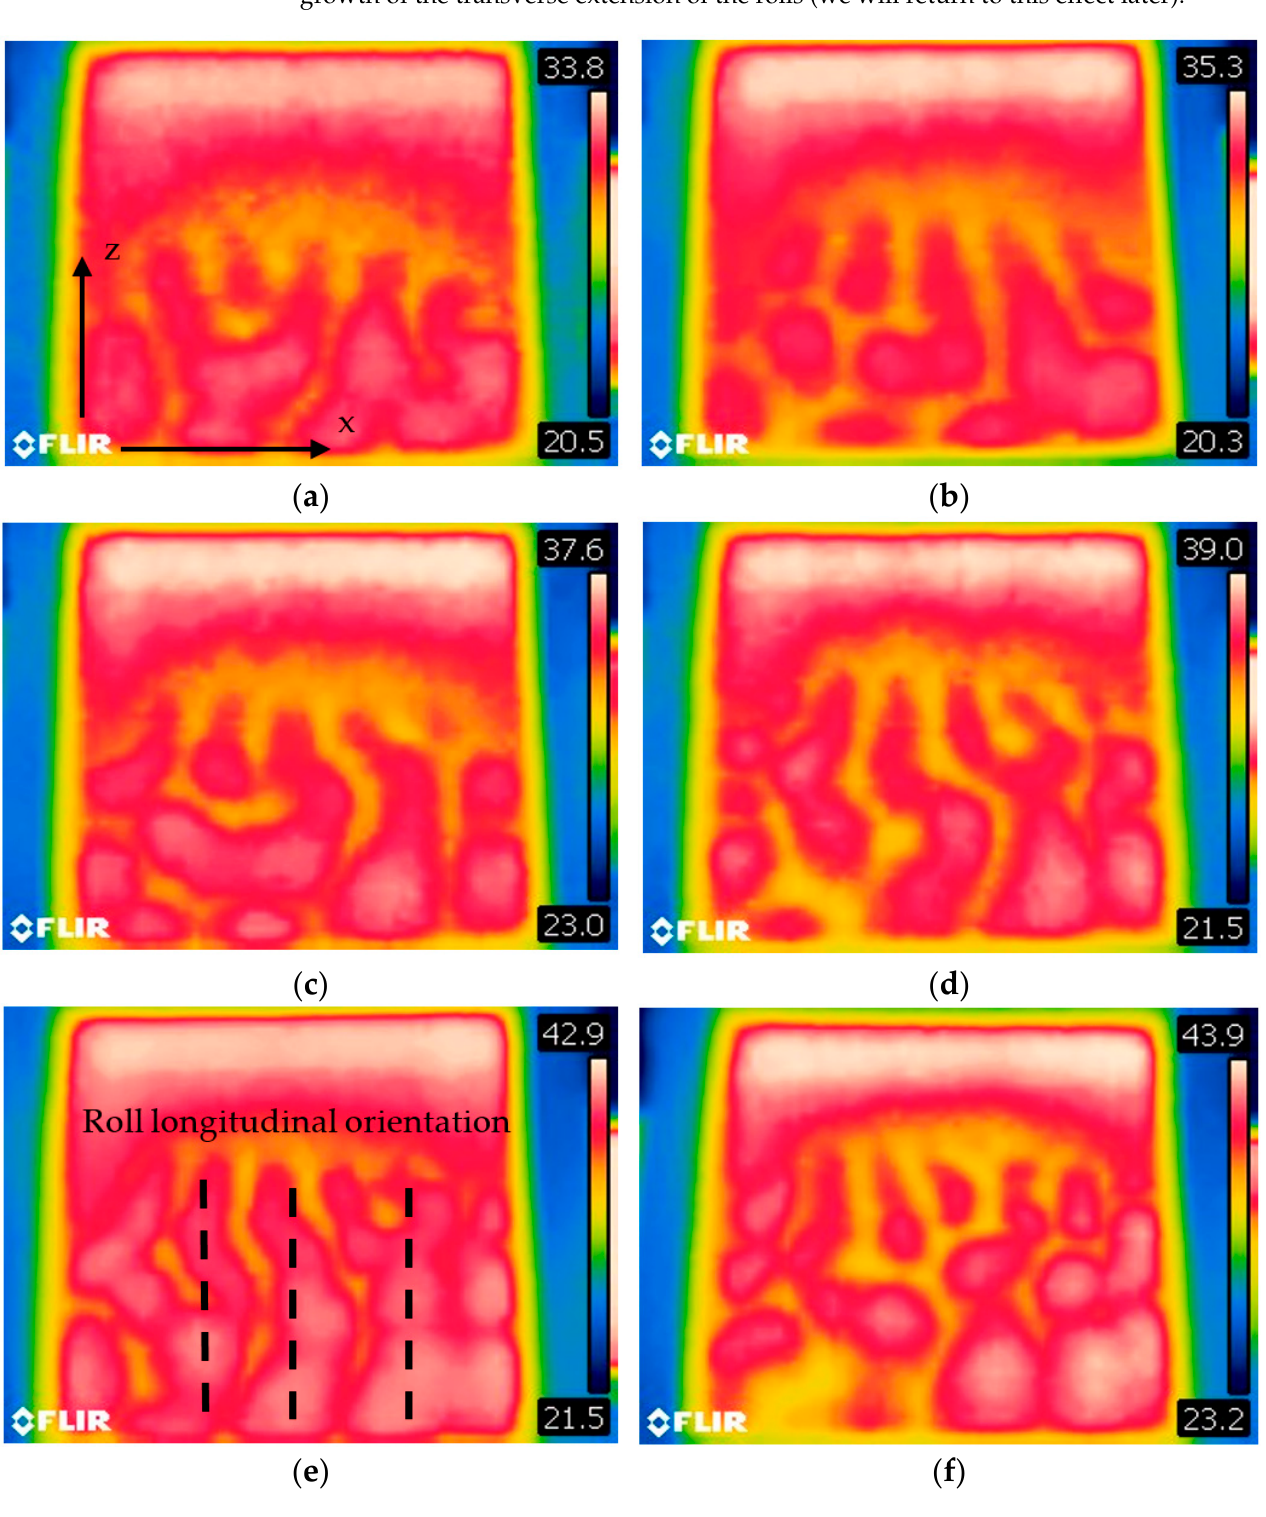
Figure 9. Surface temperature distribution for d = 0.50 cm ( Ω = 32 mL) and ϑ ≅ 5° ( A = 16, Bo dyn ≅ 0.86, Ra ≅ 2.5 × 10 2 × ∆ T , Ma ≅ 2.94 × 10 2 × ∆ T ): ( a ) ∆ T = 15 °C, ( b ) ∆ T = 18 °C, ( c ) ∆ T = 21 °C, ( d ) ∆ T = 24 °C, ( e ) ∆ T = 27 °C, ( f ) ∆ T = 30 °C (the x and z axes correspond to the horizontal and vertical directions in all the panels).